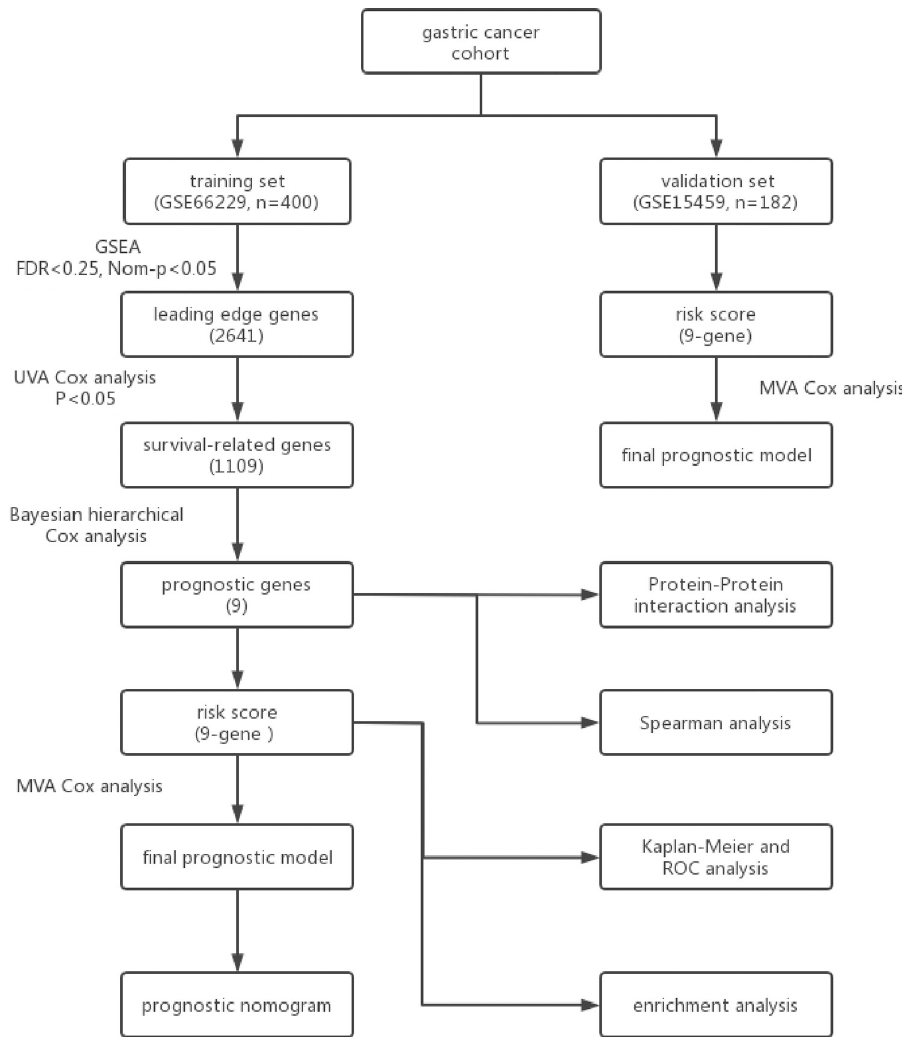
Fig 1. Schematic diagram of this study. 0.01. Our goal was to find an optimal value that simultaneously made the C-index larger and deviance smaller. According to the results of 10-fold cross-validation with repeated 10 times, we ultimately decided to choose s = s -0.04 as an optimal value (Table 2). At the same time, 0 λ the C-index and deviance of the constructed Bayesian hierarchical lasso Cox model were 0.684 (sd = 0.004) and 1582.454 (sd = 3.734), respectively. The C-index of traditional lasso Cox regression was 0.643 (sd = 0.011), which was lower than our Bayesian hierarchical lasso Cox model. Afterwards, we chose 9 prognostic genes whose coefficients were not zero, including tumour necrosis factor receptor superfamily member 11A ( TNFRSF11A ), nicotinamide nucle- otide adenylyltransferase 1 ( NMNAT1 ), eukaryotic translation initiation factor 5A ( EIF5A ), notch receptor 3 ( NOTCH3 ), torsin family 2 member A ( TOR2A ), E2F transcription factor 8 ( E2F8 ), proteasome 20S subunit alpha 5 ( PSMA5 ), thiopurine S-methyltransferase ( TPMT ), and kinesin family member 11 ( KIF11 ) (Table 3).